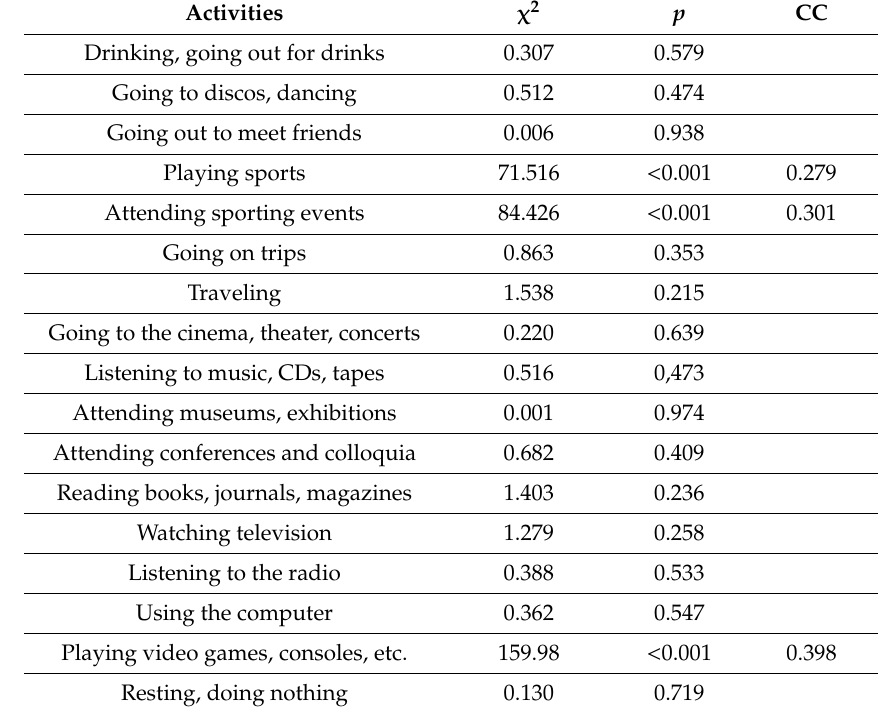
Table 2. Di ff erences in leisure activities according to